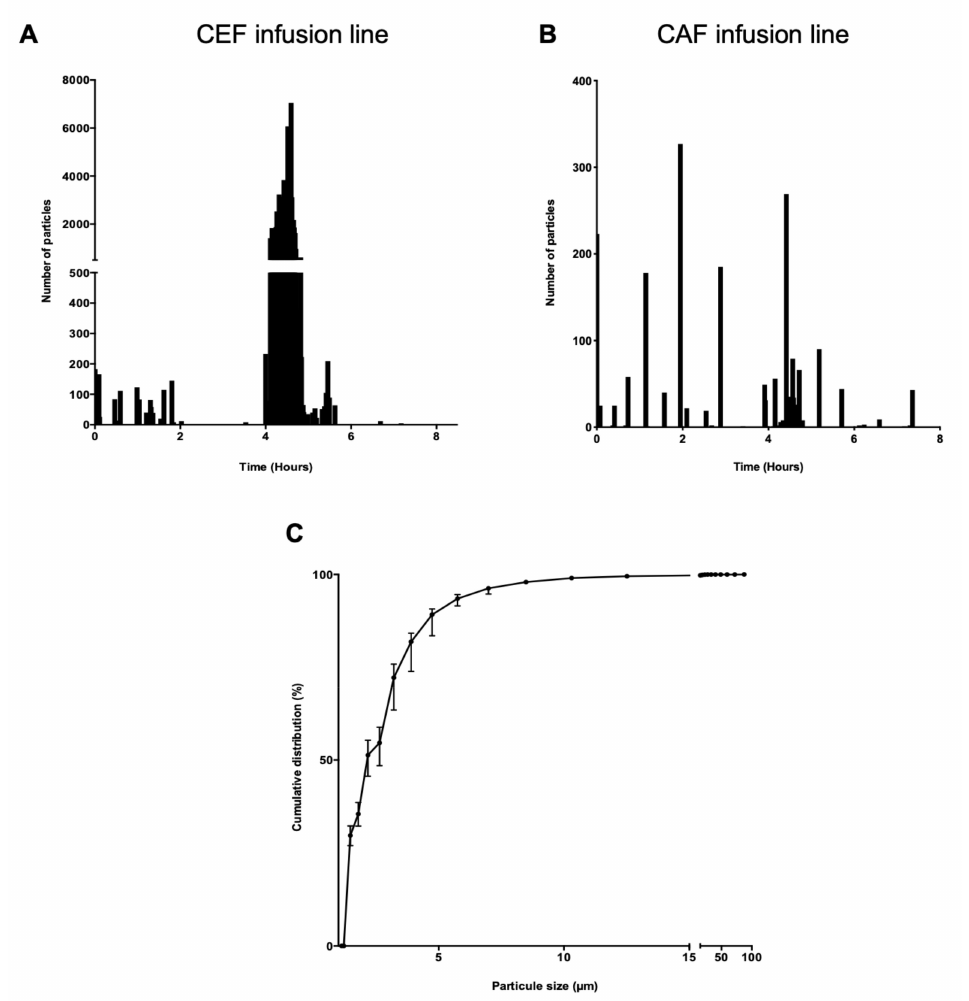
Figure 5. Example of particle distribution over time. CEF infusion line ( A ), CAF infusion line ( B ). Cumulative distribution of particles in a CEF infusion line, ( n = 6) ( C